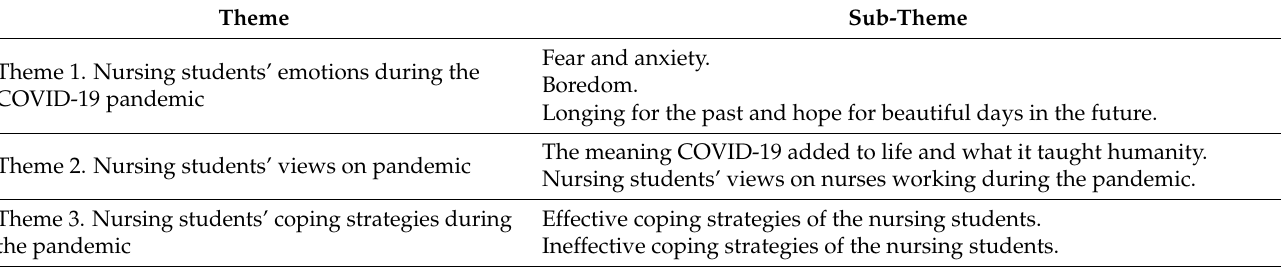
Table 2. Themes obtained from the diaries of nursing students during the first month of social restrictions of the COVID-19 pandemic. Theme Sub-Theme Fear and anxiety. Theme 1. Nursing students’ emotions during the Boredom. COVID-19 pandemic Longing for the past and hope for beautiful days in the future. The meaning COVID-19 added to life and what it taught humanity. Theme 2. Nursing students’ views on pandemic Nursing students’ views on nurses working during the pandemic. Theme 3. Nursing students’ coping strategies during Effective coping strategies of the nursing students. the pandemic Ineffective coping strategies of the nursing